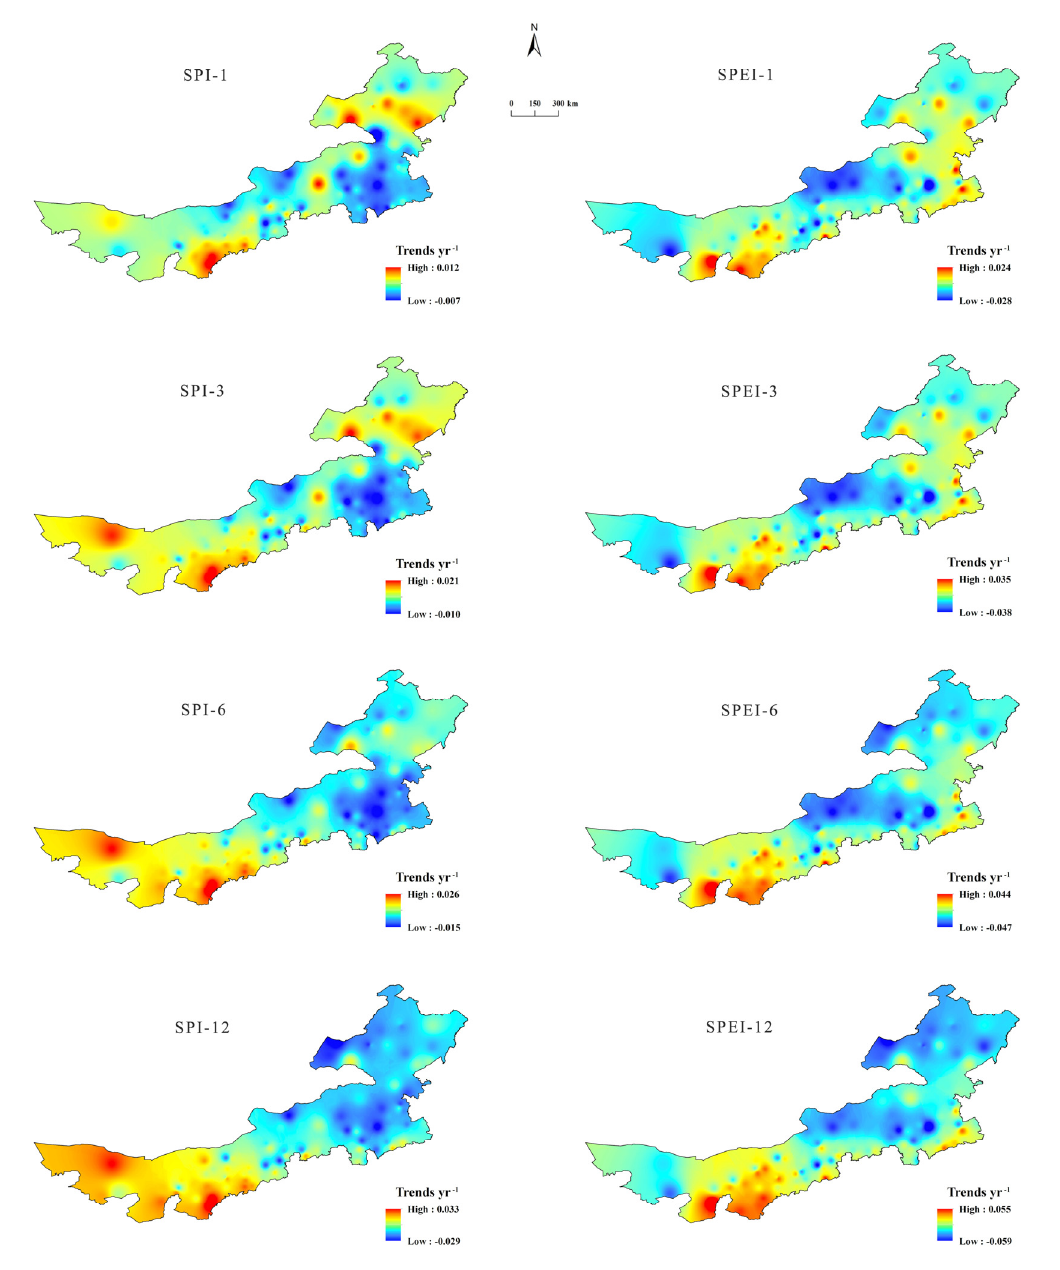
Figure 6. Spatial distribution of the SPI and SPEI trends at 1-, 3-, 6-, and 12-month timescales in Inner Mongolia during 1981–2018. Water 2020 , 12 , x FOR PEER REVIEW